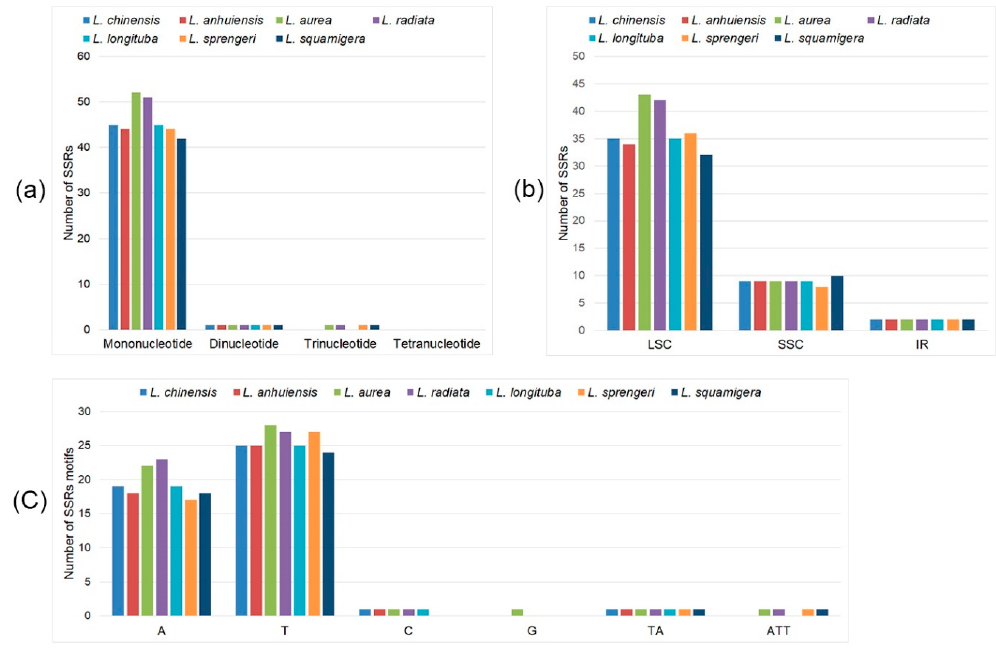
Figure 2. Analyses of simple sequence repeats of plastome in seven Lycoris species. ( a ) Numbers of different repeat types; ( b ) Frequency of repeat types in LSC, SSC, and IR regions. ( c ) Numbers of identified SSRs motifs.